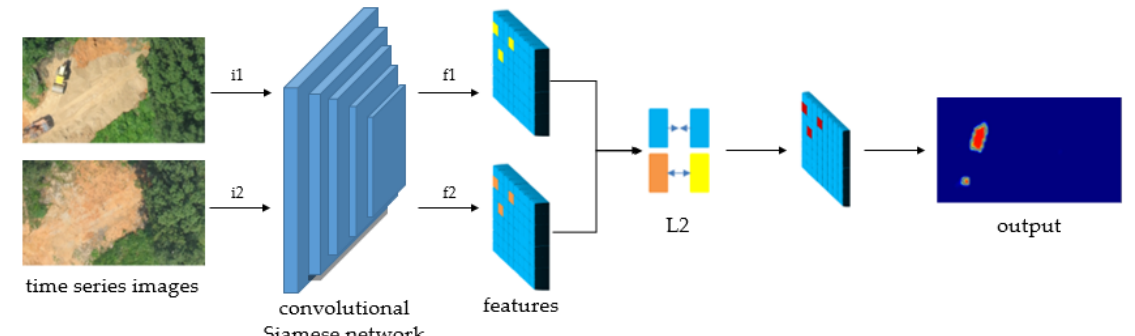
Figure 2. Overview of the proposed change detection method.